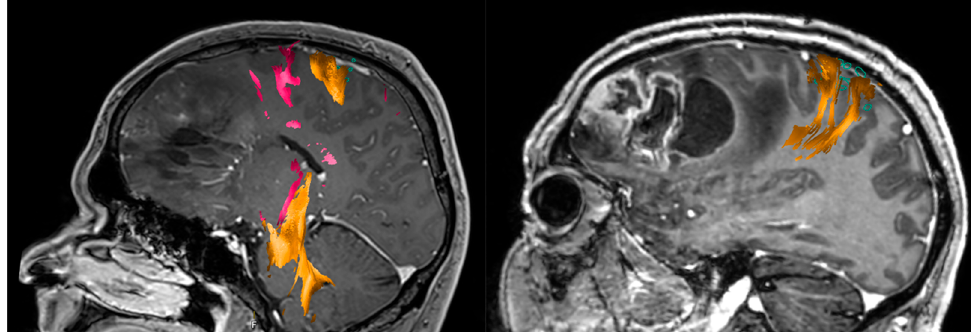
Figure 7. Tractography based on nTMS is a useful adjunct tool in the surgical treatment of glioblas-